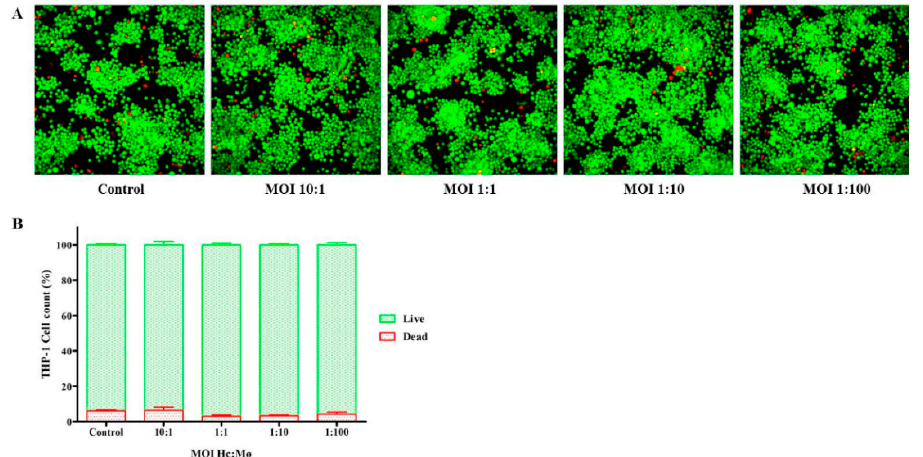
Figure 2. Viability of THP-1 Mø-like cells infected with H. capsulatum EH-315 yeasts 5 h after infection. ( A ) IN-Cell Analyzer images illustrating viable cells labeled by calcein AM (green) and dead cells labeled by EthD-1 (red). ( B ) Viability of the labeled cells obtained with the Live/Dead kit. Analyses were conducted with the IN-Cell Investigator 1000 Workstation software. Control = uninfected cells.